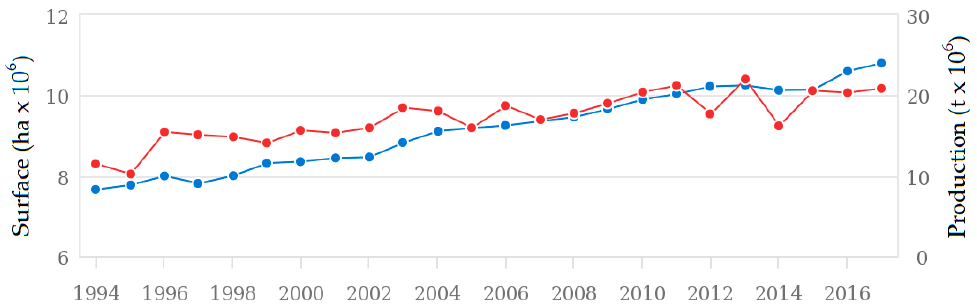
Figure 1. Total olive-tree cultivation surface (blue points) and worldwide olive production (red points) from 2001 to 2017. Reproduced with permission from FAOSTAT [5].